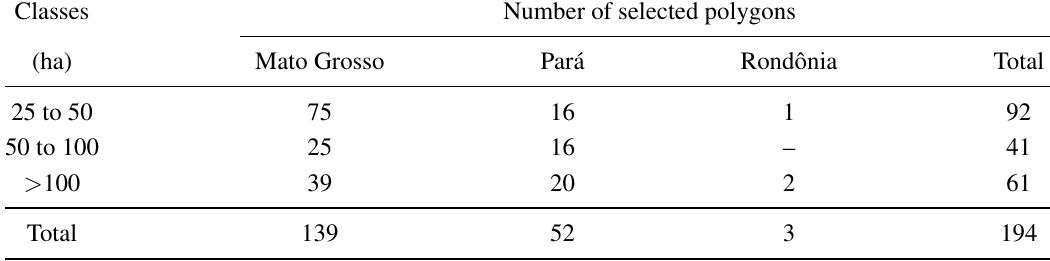
Table 5. Number of selected polygons based on MODIS image classification followed by visual analysis on TM